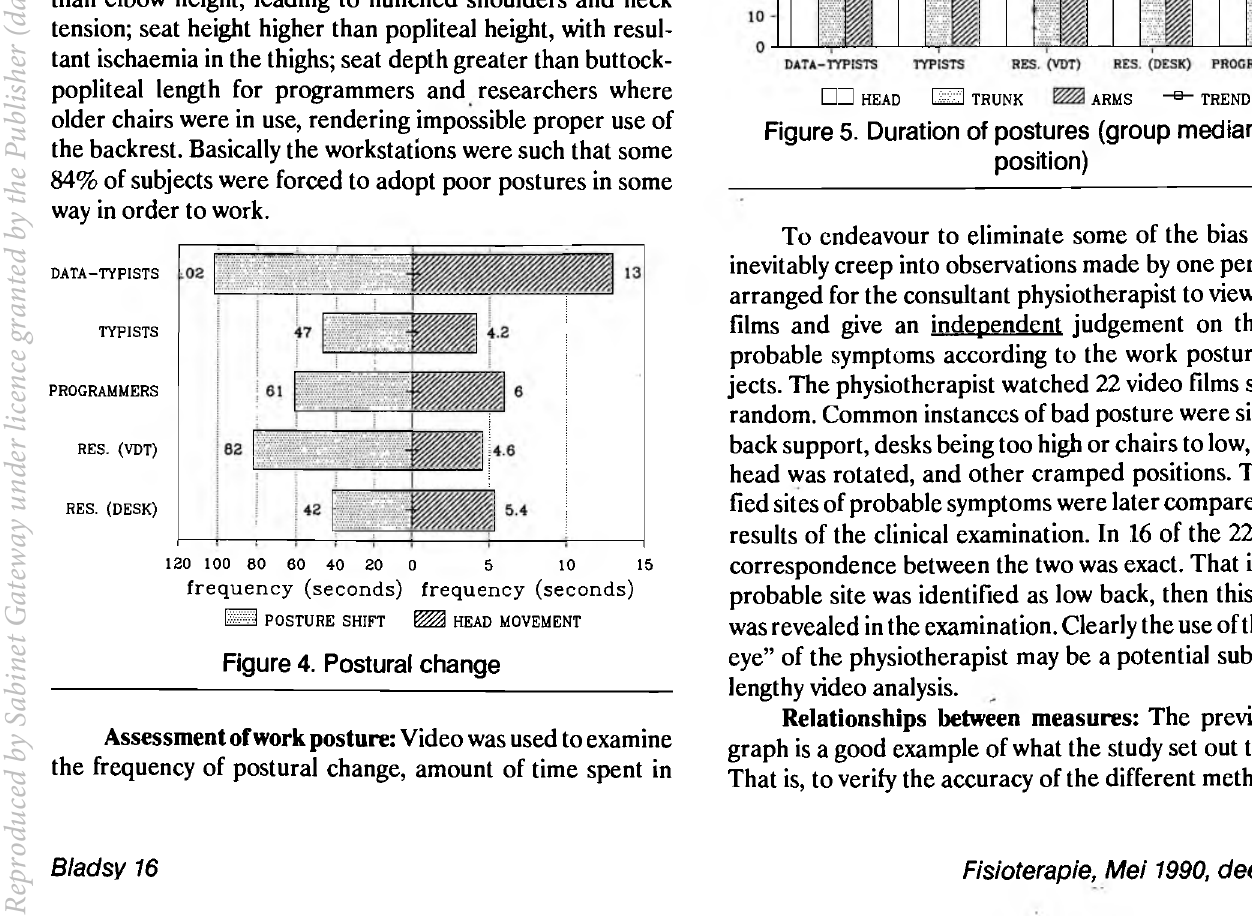
Figure 3. Classification of clinical symptoms. Table 1. Comparison of anthropometric and workstation dimensions